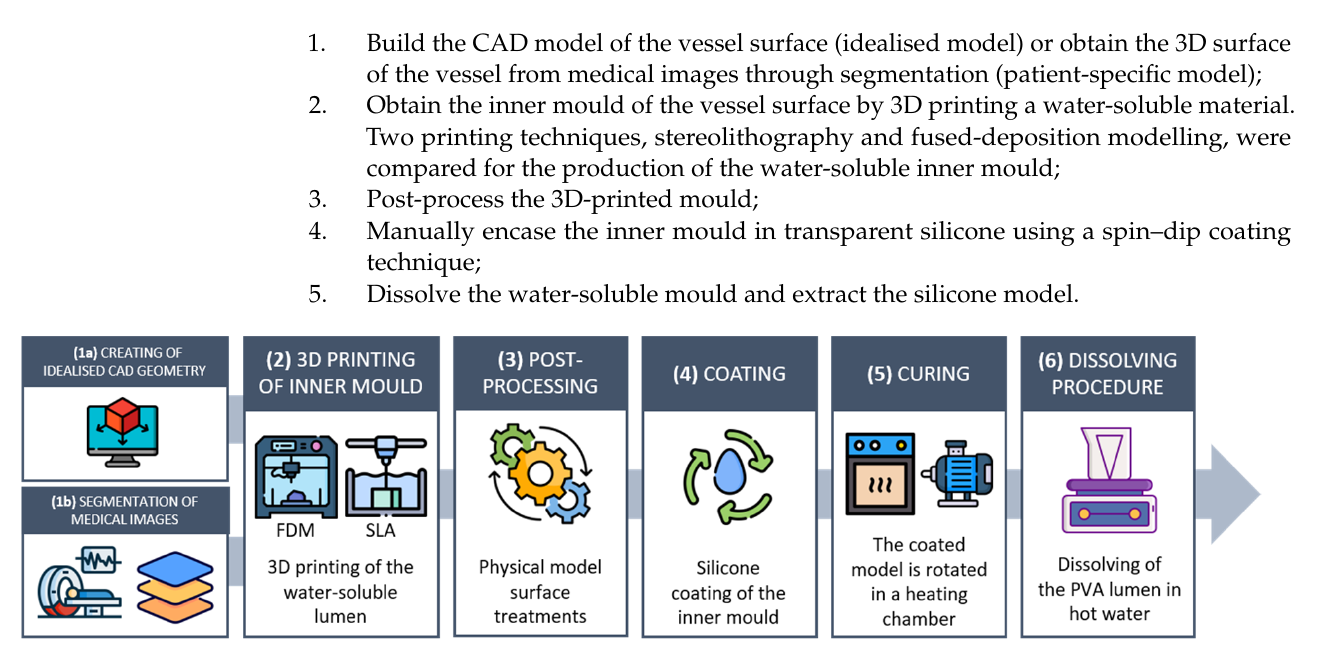
Figure 1. The proposed manufacturing process: ( 1a ) acquisition of patient-specific clinical images and segmentation to reconstruct the vasculature geometry; ( 1b ) creation of the CAD simplified geometry; ( 2 ) 3D printing of the vessel inner mould in water-soluble material; ( 3 ) physical model refinement (removal of 3D printing supports, polishing); ( 4 ) spin–dip coating and ( 5 ) curing; and ( 6 ) dissolving procedure in a hot water bath.